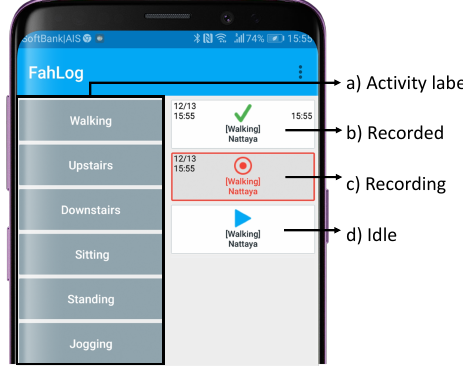
Figure 6. FahLog: a mobile app for collecting sensor data and activity labels.